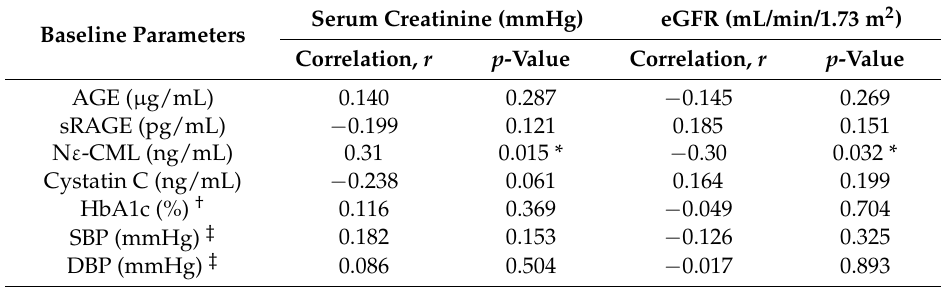
Table 4. Correlation between serum biomarkers HbA1c, SBP, and DBP with serum creatinine and eGFR.